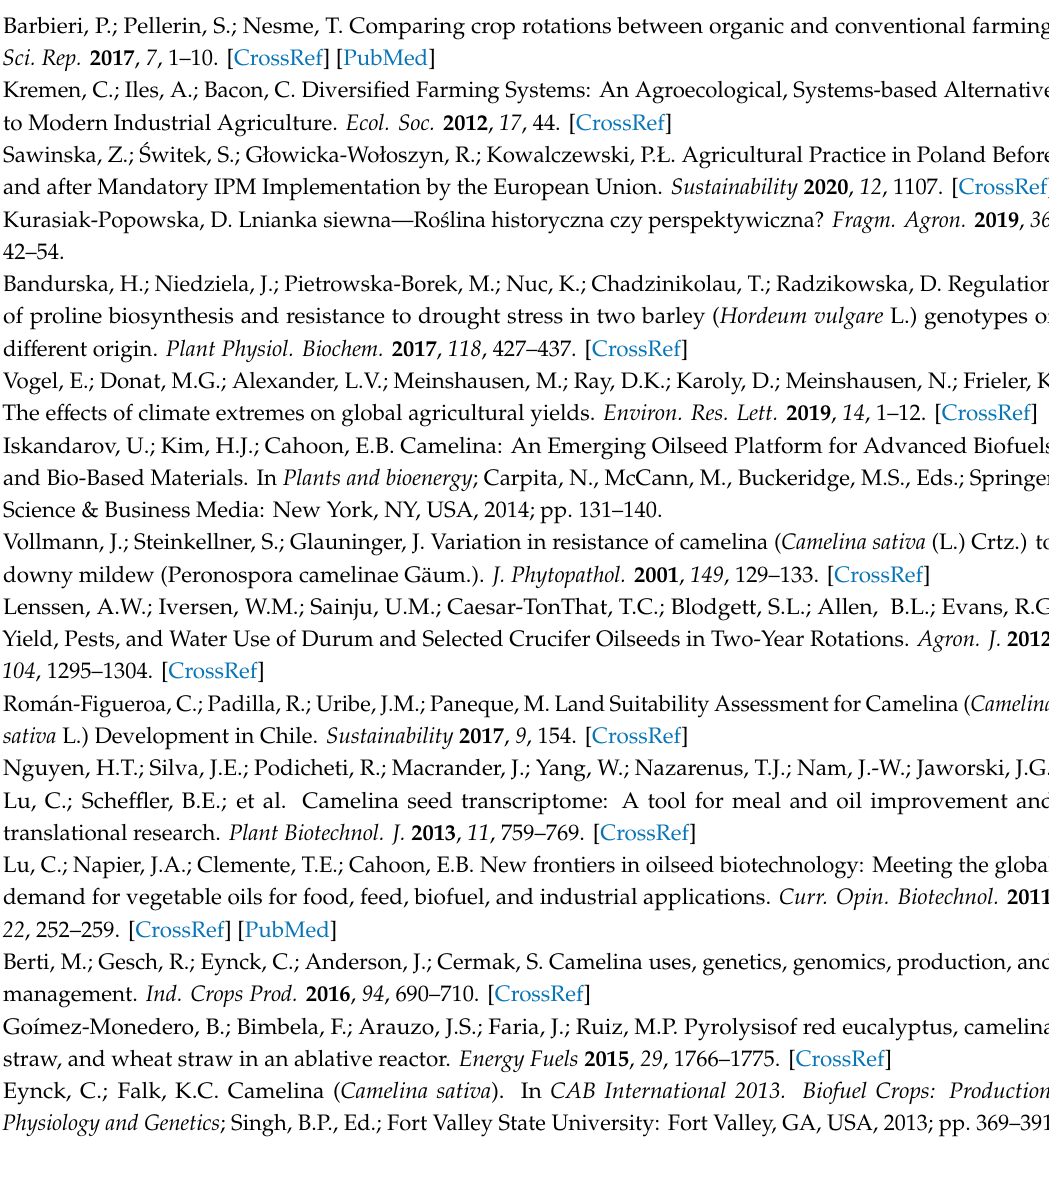
Table S1. Nucleic sequences of random amplified polymorphic DNA (RAPD-PCR)